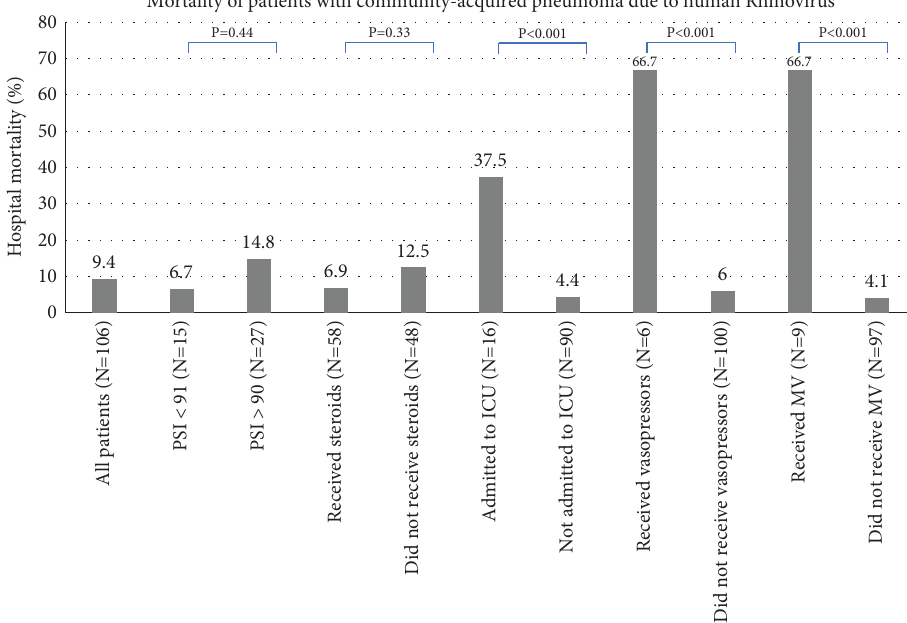
Figure 2: Hospital mortality of patients with community-acquired pneumonia due to human rhinovirus is categorized by important clinical exposures. ICU: intensive care unit, PSI: pneumonia severity